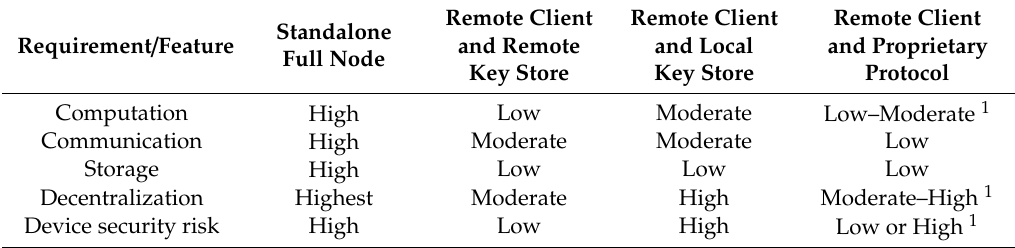
Table 3. Comparison of deployment options.